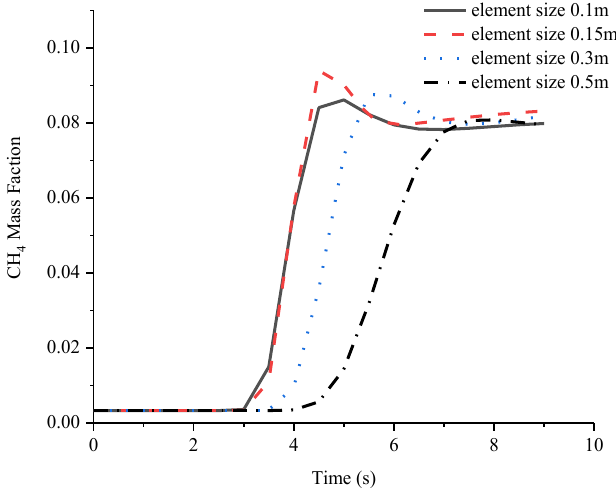
Figure 2. The influence of different mesh sizes on the calculation results .